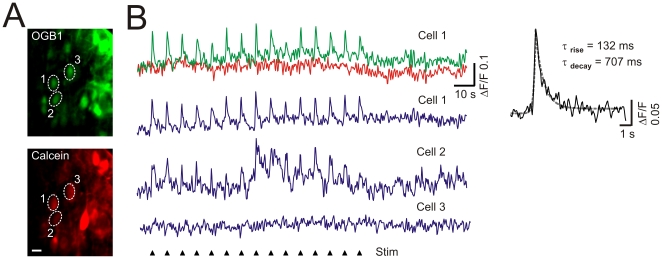

In vivo Ca2+ imaging of adult spinal lamina I neurons.(A) Spinal lamina I neurons double-labeled with Ca2+ dye OGB1 (green) and with the Calcein structural dye (red). ROIs (dashed circles): three selected neurons for (b). Scale bar, 10 µm. (B) The fluorescence intensity fluctuation over time in response to an electrical stimulation of the sciatic nerve (15 pulses of 1 ms, 5 mA at 0.1 Hz) for OGB1 (green trace, Cell 1), Calcein (red trace, Cell 1) and their subtraction (blue trace, Cell 1, 2, 3). Cell 1 and 2, but not Cell 3 displayed Ca2+ transients evoked by each stimulus (black arrow heads). Right trace: two exponential functions (one for the rise, one for the decay) were fitted to the Ca2+ dynamics (Cell 1) averaged over the 15 single trials. τdecay and τrise were extracted (Inset).